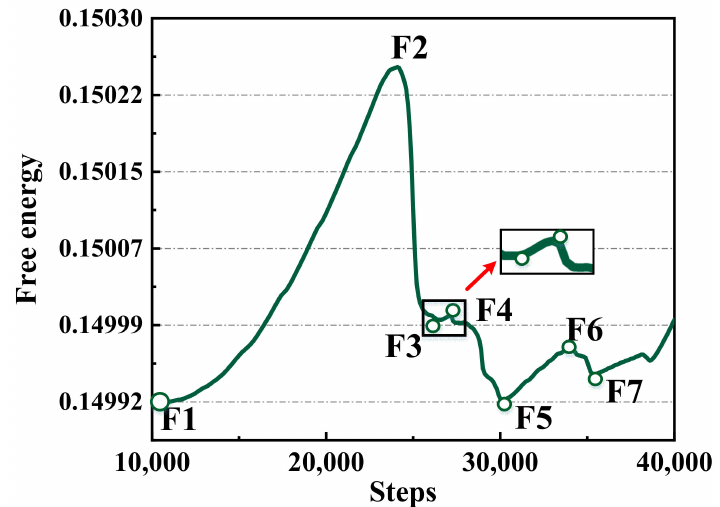
Figure 4. Free energy curved of dislocations evolution of the sample A. F1–F7 represent energy value points.